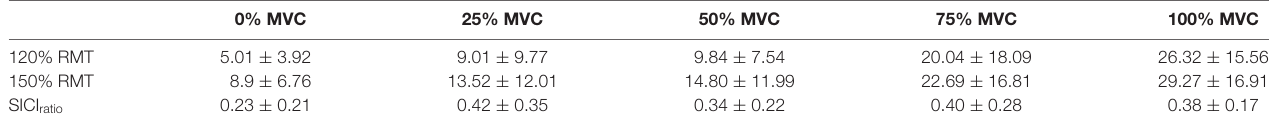
TABLE 2 | Motor evoked potential (MEP) amplitudes (% M max ) and short-interval intracortical inhibition (SICI) ratio obtained during Experiment 1 (Mean ±